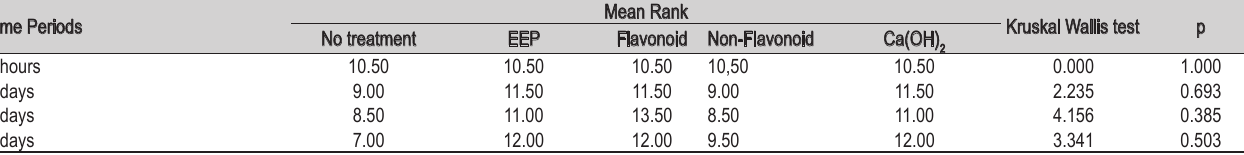
Table 2 - The difference of collagen type I density among groups for each time period.